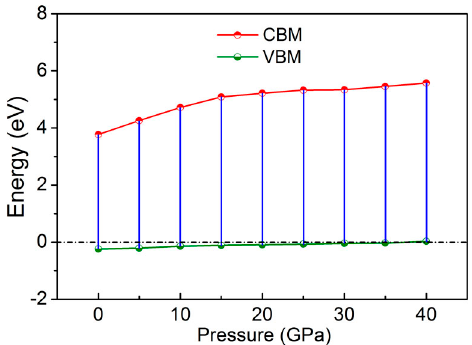
Figure 7. Conduction band minimum (CBM) and valence band maximum (VBM) of GaFe(CN) 6 in majority-spin under different pressures.